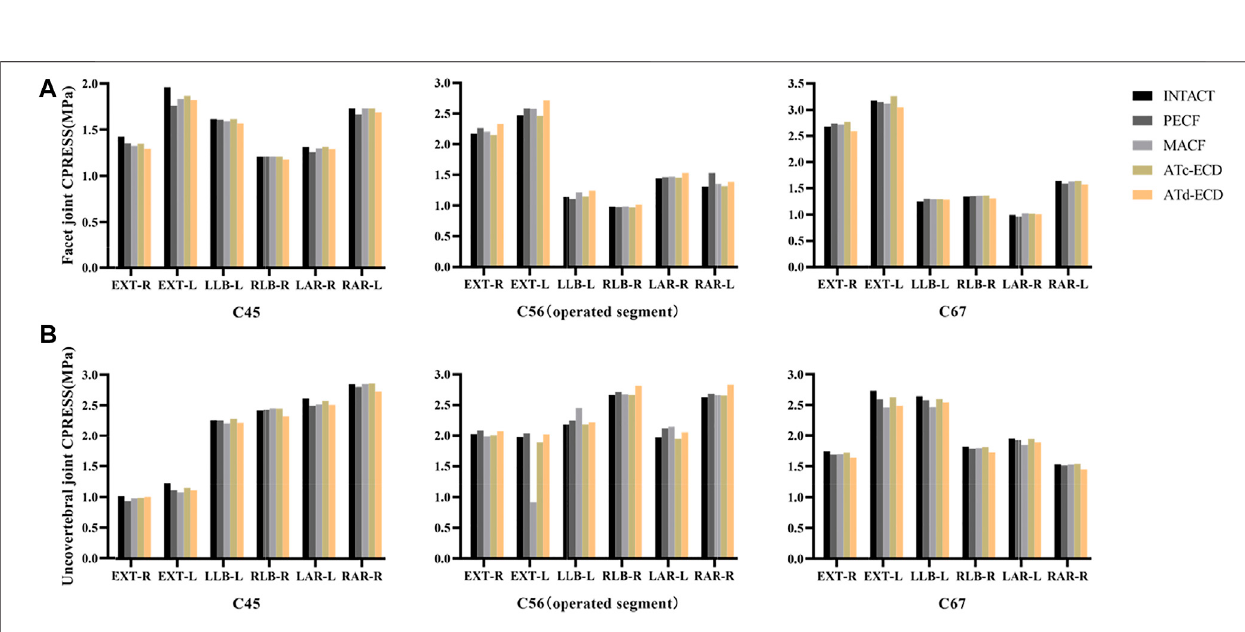
FIGURE7| TheFJsCPRESSandUJsCPRESSofC4 – C5,C5 – C6,andC6 – C7intheintactmodelandsurgicalmodels.( A )-R,rightfacetjoint;-L,leftfacetjoint.( B ) -R, right uncovertebral joint; -L, left uncovertebral joint. Ipsilateral UJ and FJ bear major pressure during lateral bending, whereas ipsilateral UJ and contralateral FJ bear major pressure during axial rotation. FLE, fl exion; EXT, extension; LLB, left lateral bending; RLB, right lateral bending; LAR, left axial rotation; RAR, right axial